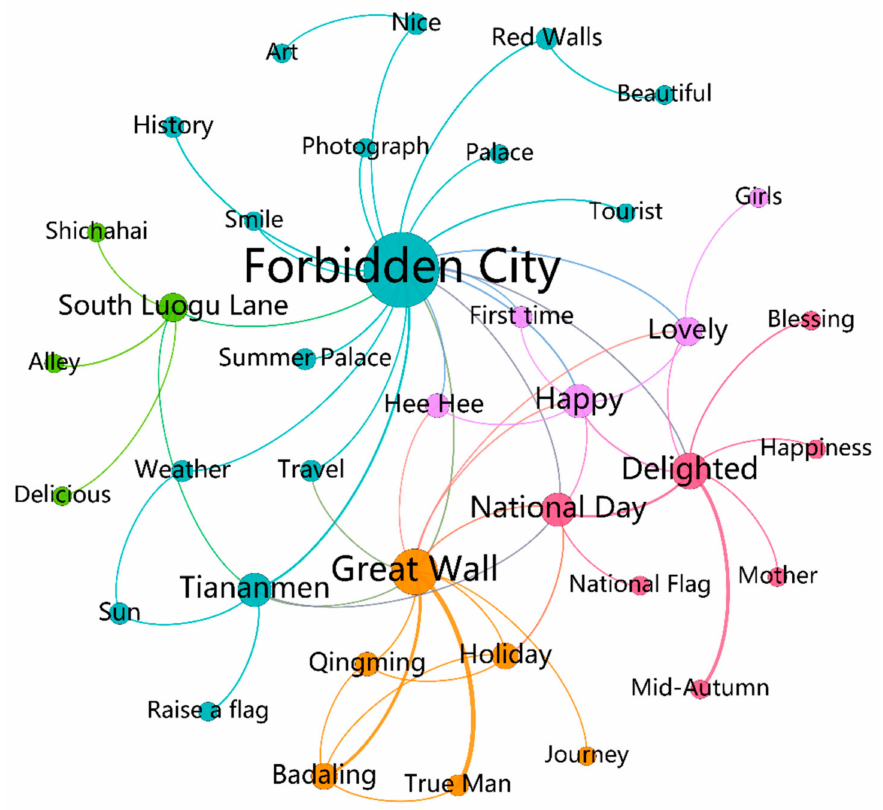
Figure A1. The positive sentiment profile of tourist flows linked to attractions in the